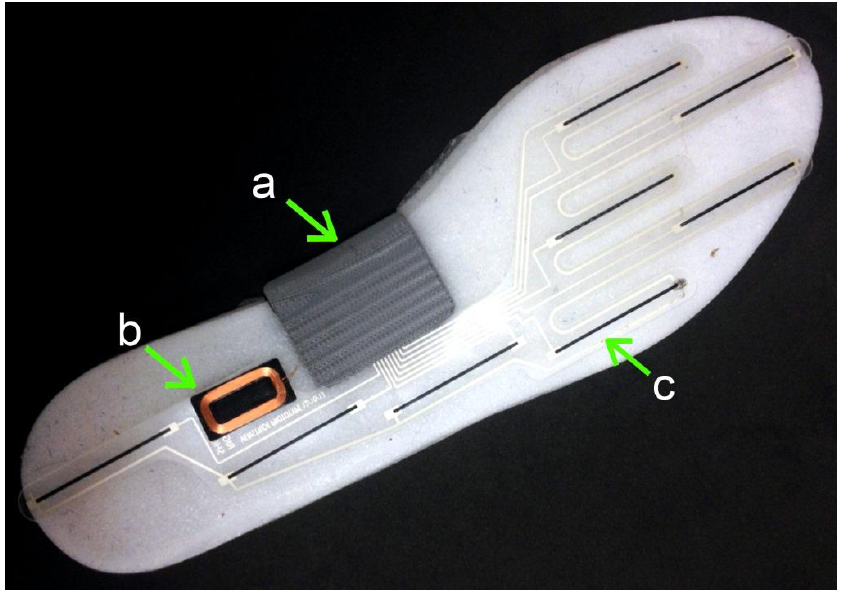
Figure 8. Instrumented insole: ( a ) inertial sensor, Bluetooth, microcontroller and battery module; ( b ) coil for inductive recharging; and ( c ) pressure sensors. Reproduced with permission from Stacy Morris Bamberg (Veristride, Salt Lake City, UT, USA).